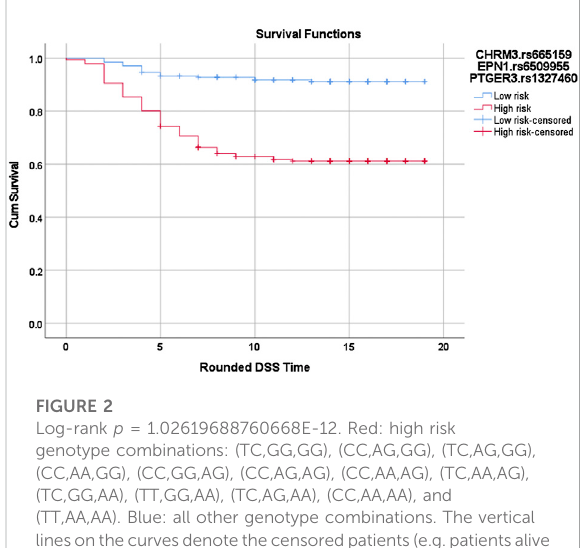
FIGURE 2 Log-rank p = 1.02619688760668E-12. Red: high risk genotype combinations: (TC,GG,GG), (CC,AG,GG), (TC,AG,GG), (CC,AA,GG), (CC,GG,AG), (CC,AG,AG), (CC,AA,AG), (TC,AA,AG), (TC,GG,AA), (TT,GG,AA), (TC,AG,AA), (CC,AA,AA), and (TT,AA,AA). Blue: all other genotype combinations. The vertical linesonthecurvesdenotethecensoredpatients(e.g.patientsalive at the last follow up time). X and Y axis show the follow-up time (in years; rounded) and cumulative survival,